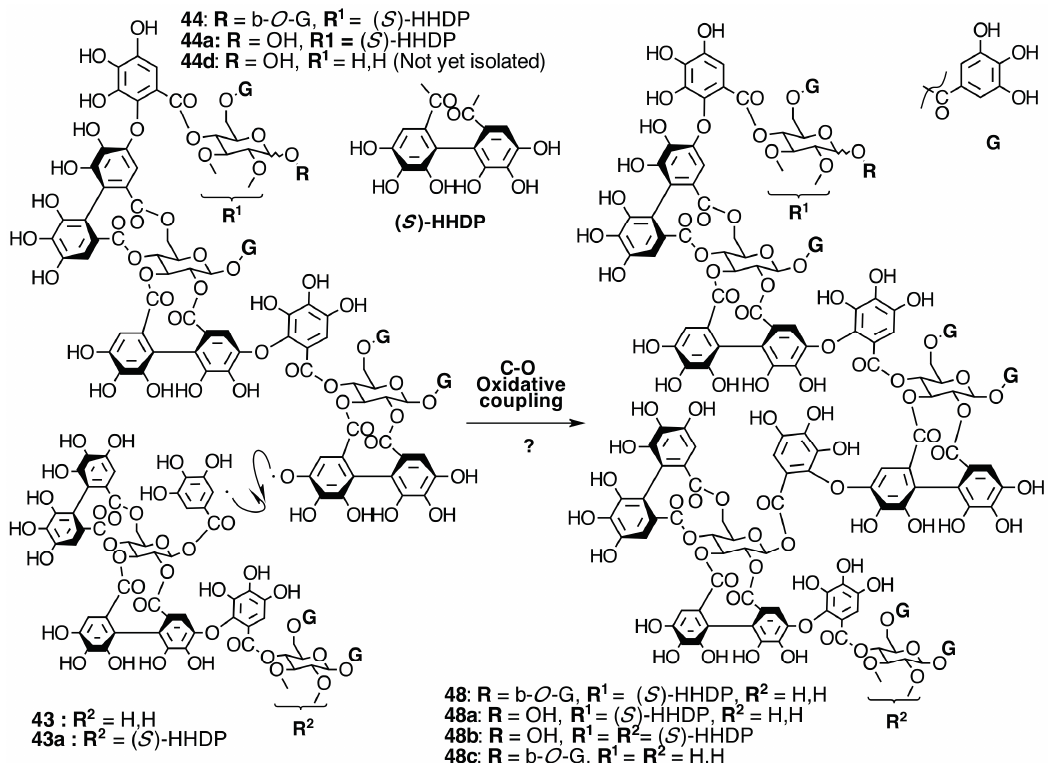
Figure 22. Route ES in the biogenesis of pentameric ellagitannins in Melastomataceae. ? = Enzymes and reaction conditions are not yet